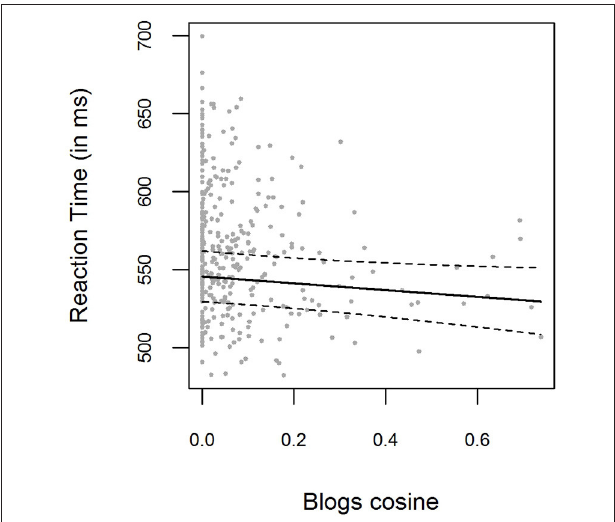
FIGURE 4 | Mean RTs for each item in the pooled data from Experiment 1 and Experiment 2, plotted as a function of the prime-target Blogs cosine similarity. The solid line shows the exponentiated model predictions of the model including cosine fixed effects, with the corresponding 0.95 confidence interval (dashed